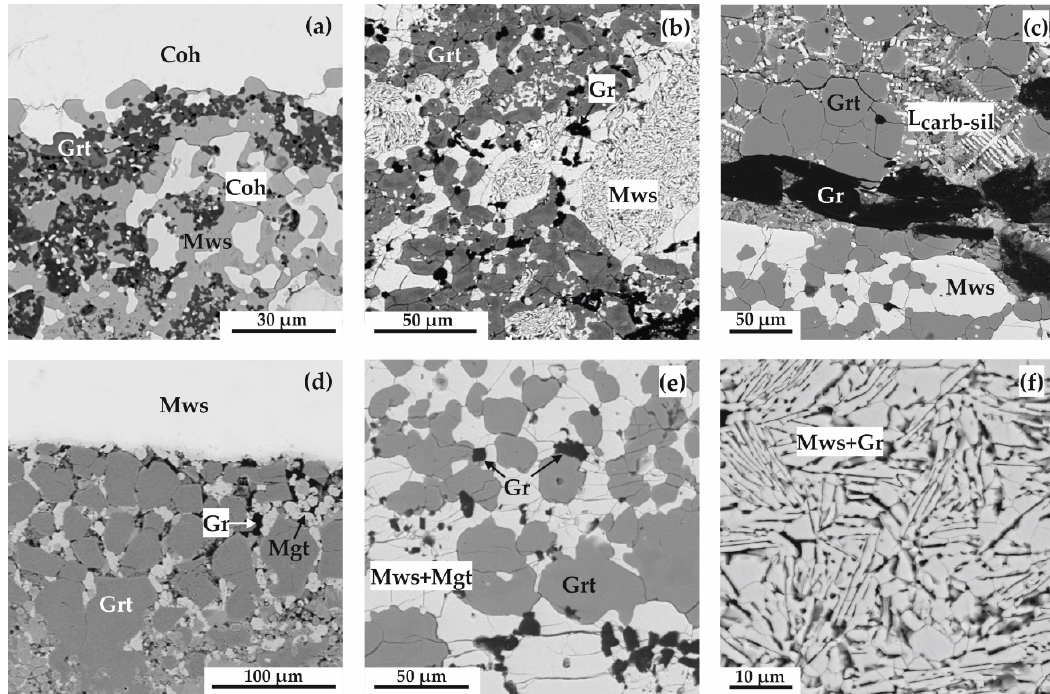
Figure 7. SEM photographs of sample fragments produced in carbonate-oxide-metal ( a – c ) and carbonate-oxide ( d – f ) systems: ( a ) reduced zone (cohenite + magnesiowüstite + garnet) (1150 °C); ( b ) oxidized zone (magnesiowüstite + garnet + graphite) (1450 ° С ); ( c ) (bottom) polycrystalline aggregate of magnesiowüstite, garnet and graphite; (top) – garnet and graphite in a quenching aggregate (1550 ° С ); ( d ) reaction zone consisting of almandine, graphite and magnetite at the contact with magnesiowüstite (1150 °C); ( e ) polycrystalline aggregate of magnesiowüstite, magnetite, graphite and garnet (1250 °C); ( f ) polycrystalline aggregate of magnesiowüstite and graphite (1350 °C); Coh: cohenite, Grt: garnet, Mws: magnesiowüstite, Mgt: magnetite, Gr: graphite, L carb-sil : carbonate-silicate melt.